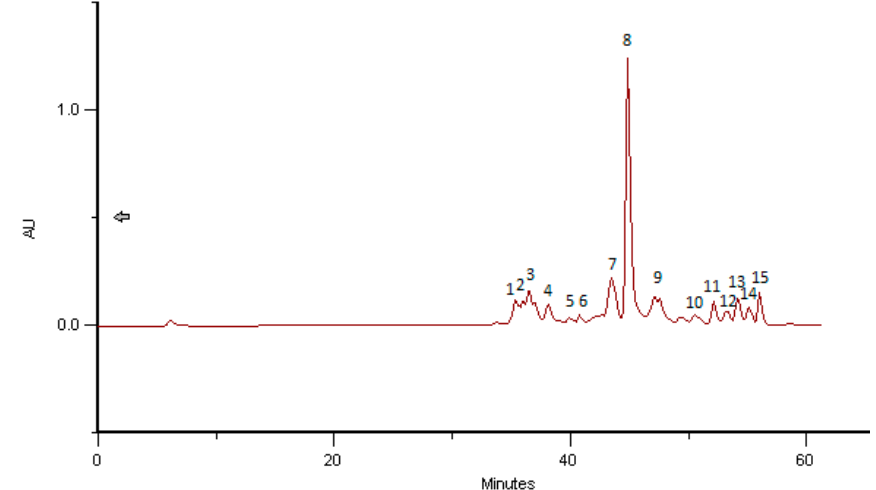
Figure 7. HPLC/DAD profile of BB Romania, June 2016 that correspond to Fabaceae — Trifolium (34.6%), Tiliaceae — Tilia sp. (22%), Fabaceae (13%), Rosaceae (7.5%), Plantaginaceae — Plantago (5%), Fabaceae — Lotus (7.5%), Asteraceae — Taraxacum officinale (3%), Asteraceae (3%), Lamiaceae (2.9%), Asteraceae — Centaurea montana (1.5%). Compound 1 = kaempferol-3- O -derivative, compounds 2 and 3 = quercetin-3- O -derivative, compound 4 = isorhamnetin-3- O -derivative. All the remain compounds are phenolic acid derivatives (data in line with Campos and Markham [34]).